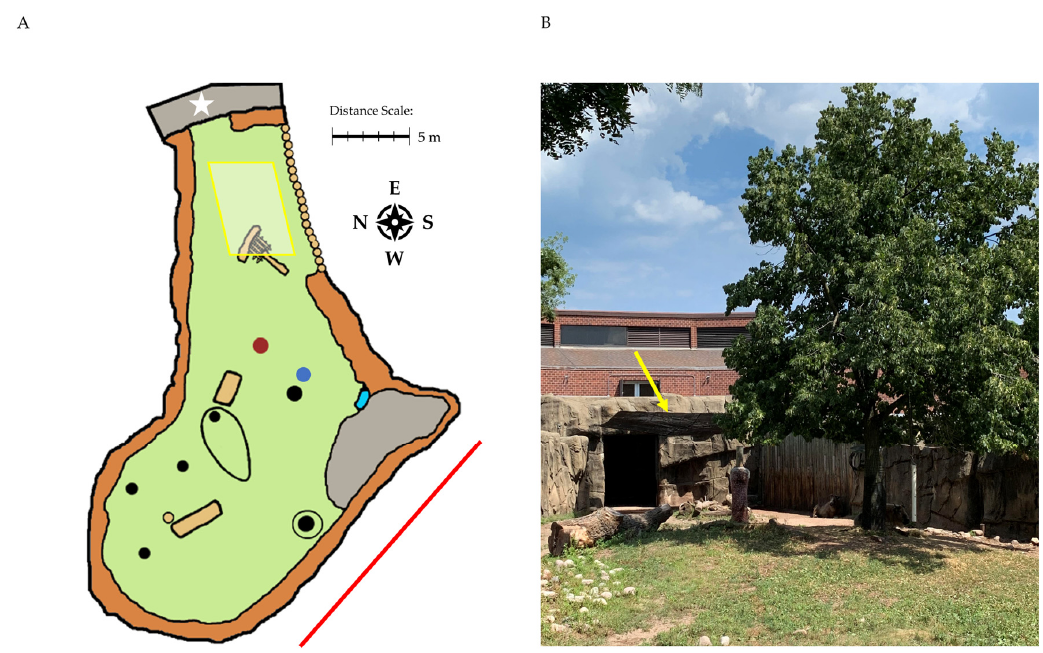
Figure 1. The Sichuan takin enclosure at Lincoln Park Zoo: ( A ) map showing features of the enclosure; ( B ) a photo showing the shade sail modification installed during the study. The position of the added shade sail is indicated in ( A ) with a yellow rectangle and in ( B ) with a yellow arrow. Also shown in ( A ) are a scratching post (red dot), hanging feeder (blue dot), trees (black dots), logs (tan rectangles), rock boundaries (black circles), visitor viewing area (red line), and access to indoor areas (white star).